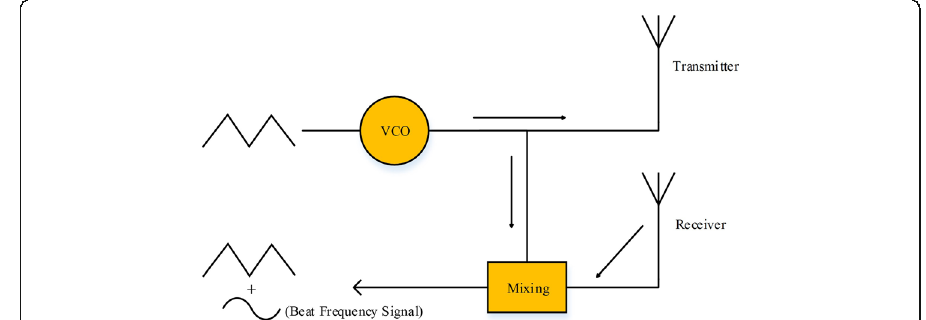
Fig. 3 Block diagram of the FMCW distance